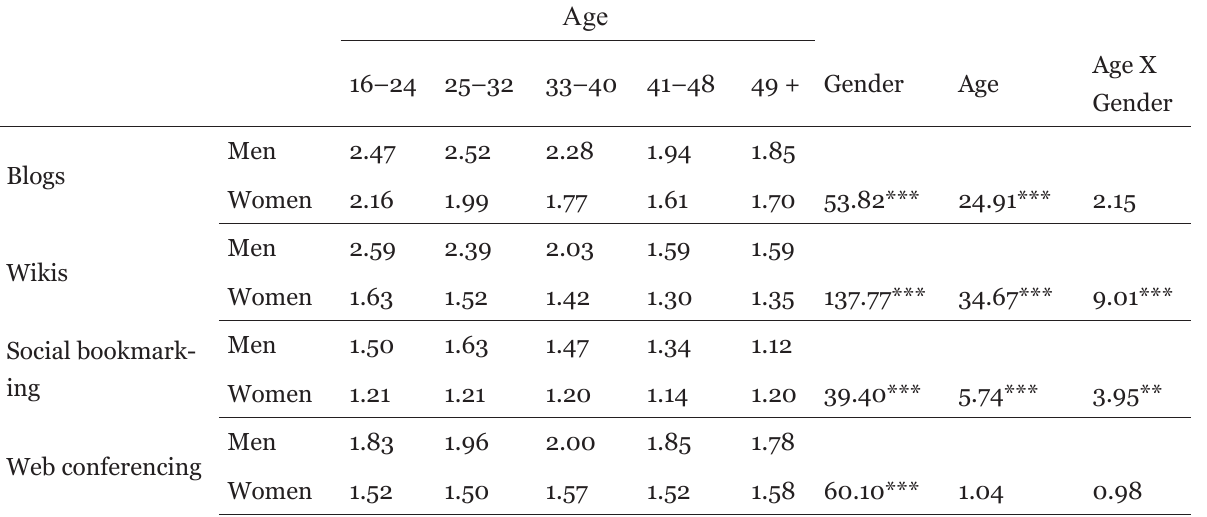
Self-Professed Expertise with Social Software by Age and